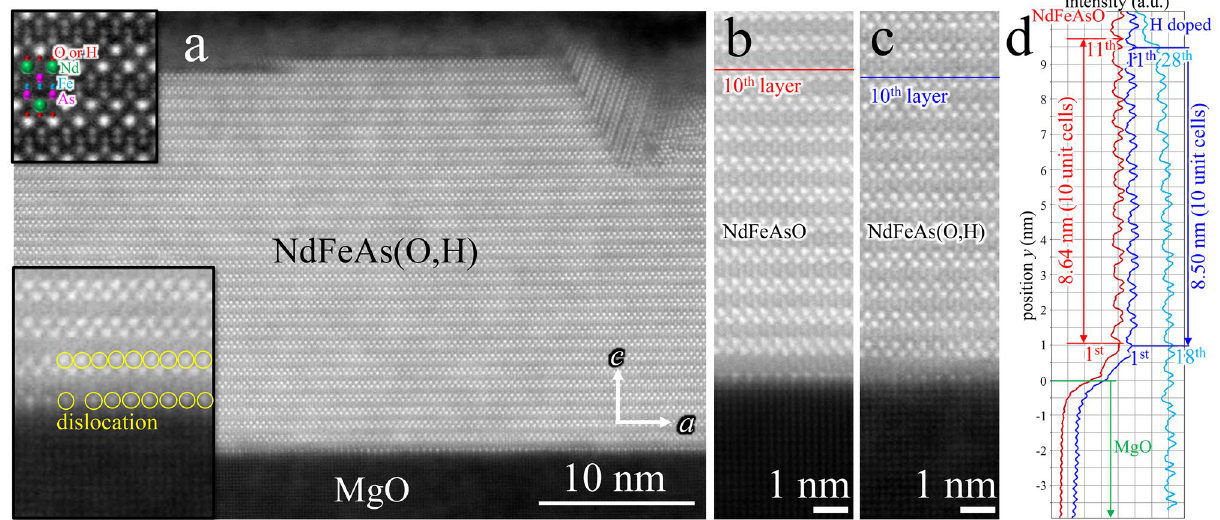
Figure 1. Microstructural analysis by TEM. ( a ) TEM cross-sectional view of the NdFeAs(O,H) epitaxial thin film revealed almost no apparent defects. Additionally, no reaction layer between the film and the MgO substrate was observed. ( b ) The magnified ADF images of NdFeAsO and ( c ) NdFeAs(O,H). ( d ) Image intensity profiles along the c -axis direction extracted from ( b ) and ( c ), averaged in the a -axis direction. The c -axis lattice parameters averaged over 10 layers are 8.64 Å and 8.50 Å, respectively. The distances from the 1st to the 11th layer and from the 18th to the 28th layer are the same in the NdFeAs(O,H)